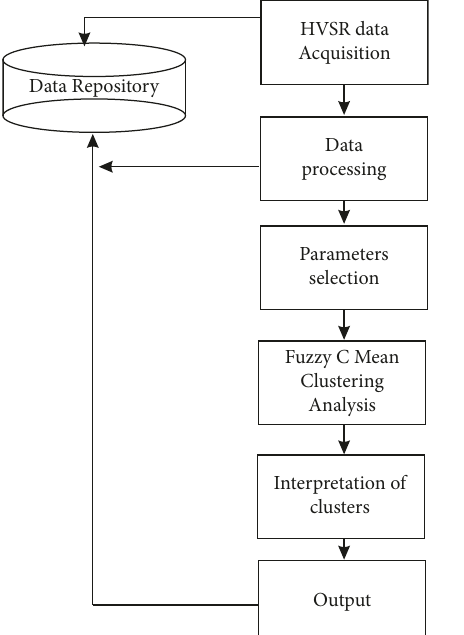
Figure 2: Flowchart indicating the stages performed for fuzzy C- mean clustering analysis in this research work.